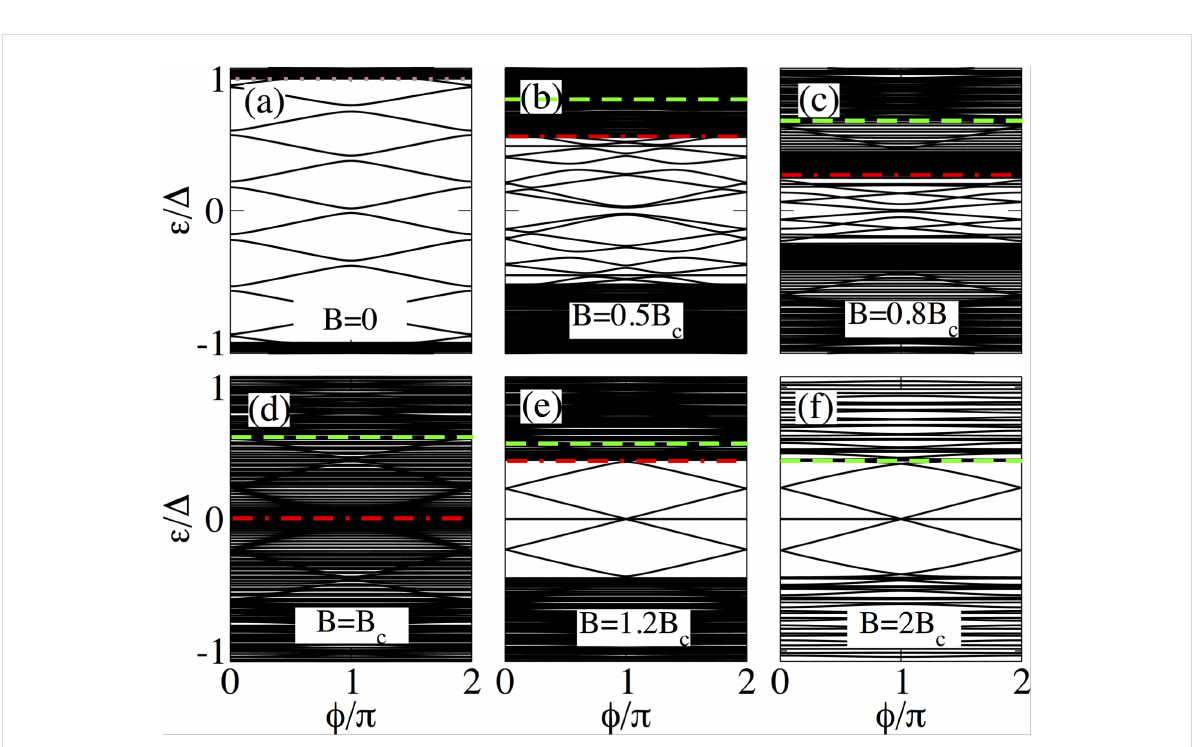
Figure 7: Same as in Figure 4 for a long junction with L N = 2000 nm and L S = 10000 nm. The four lowest levels coexist with additional levels. The outer MBSs lie at zero energy and the inner ones reach zero at = π acquiring Majorana